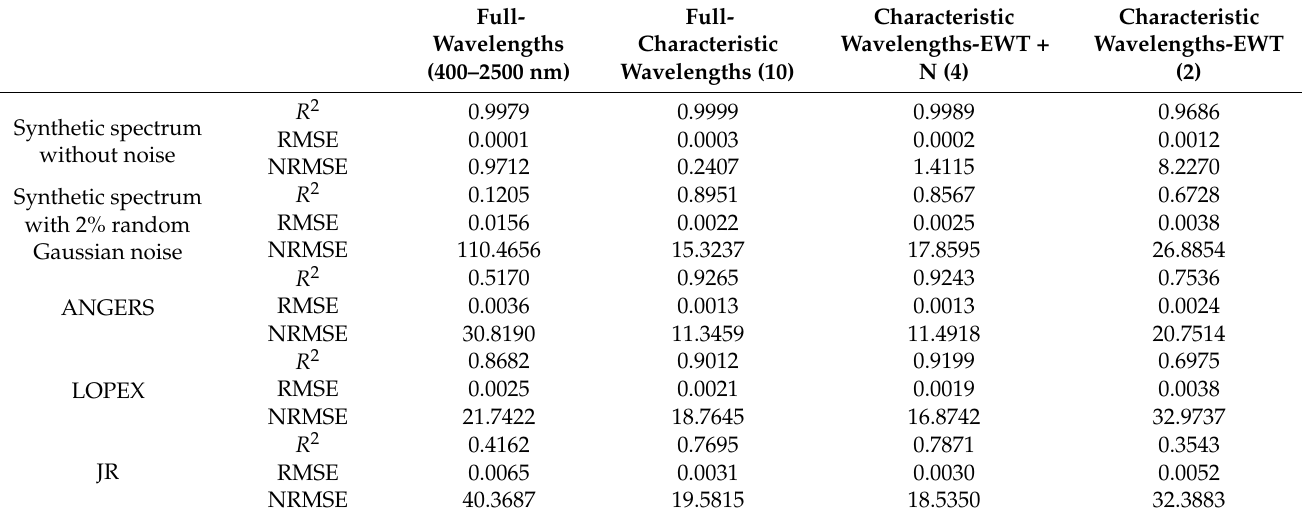
Table 5. Performance of different numbers of wavelengths for EWT estimation by using